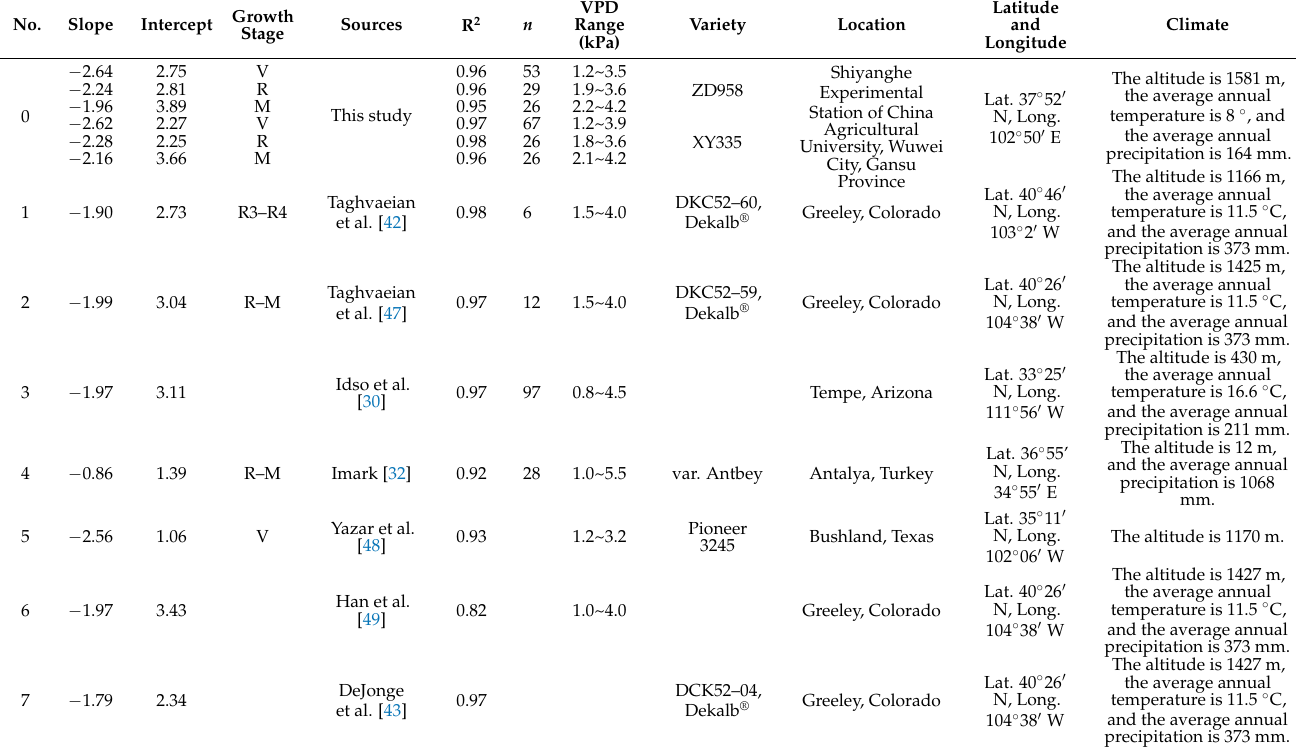
Table 2. Slope, intercept, and other detailed parameters of non-water-stressed baselines’ (NWSBs) linear fitting reported in this study and previous maize